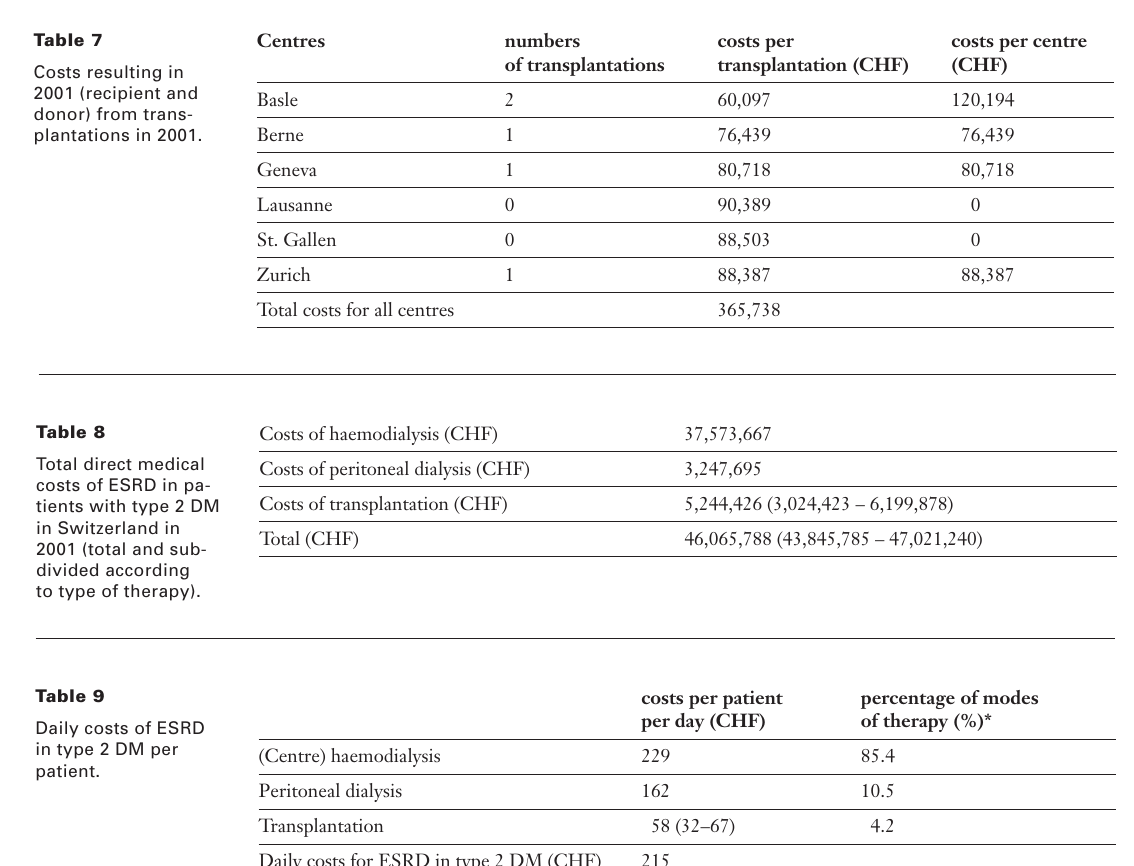
Costs resulting in 2001 (recipient and donor) from trans- plantations in 2001.